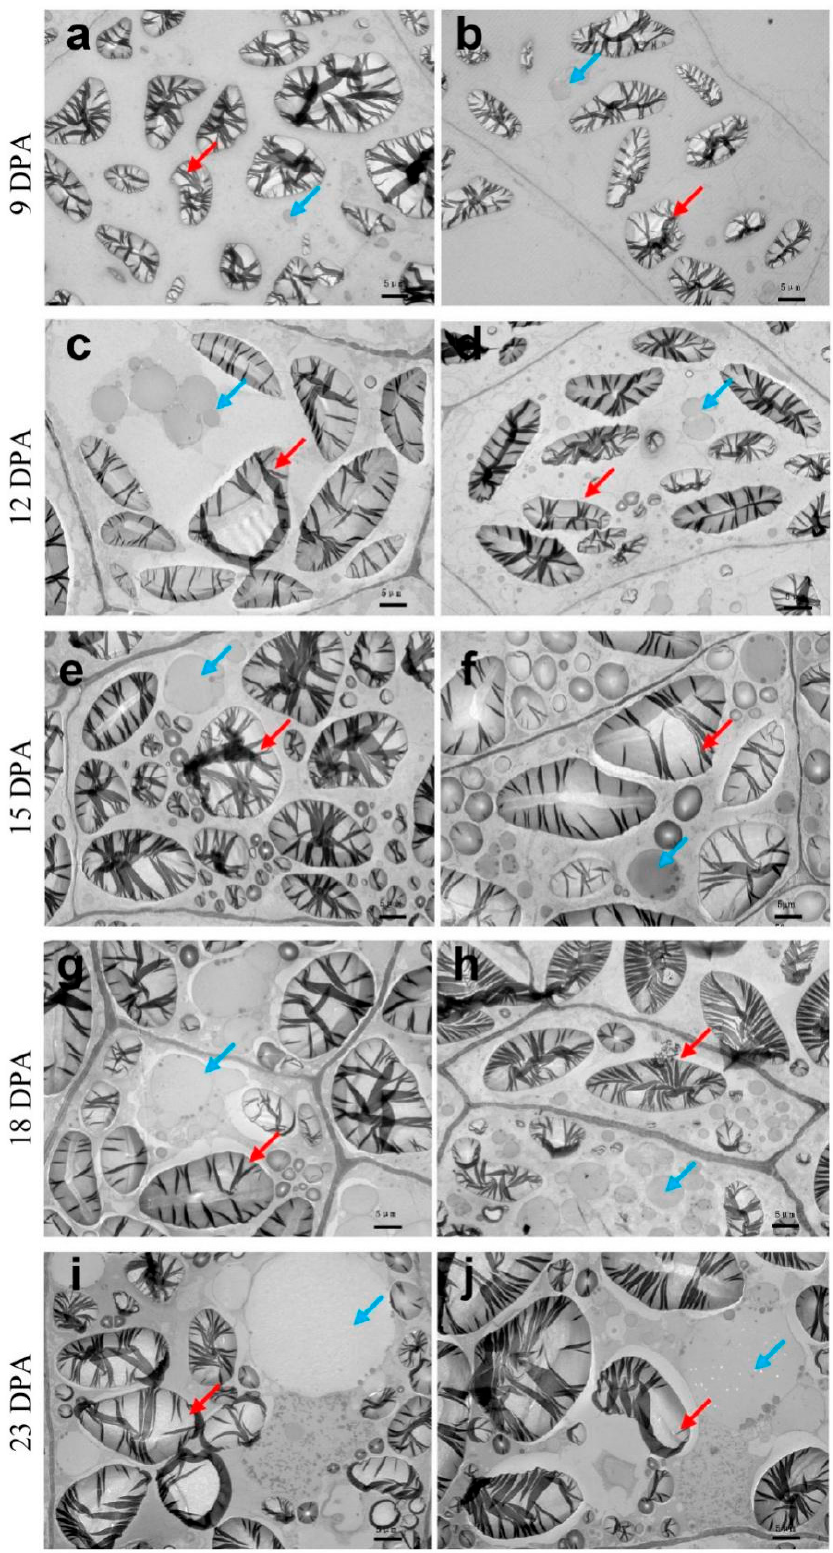
Figure 5. Starch granule and protein body in normal and embryoless wheat grains during grain-filling in the mtl mutants. ( a , c , e , g , i )The dynamic change of starch granule (SG) and protein body (PB) in normal grains; ( b , d , f , h , j ) The dynamic change of SG and PB in embryoless grains. The SG were highlighted by red arrows, and the PB were highlighted by blue arrows. Scale bar = 5 μ m.